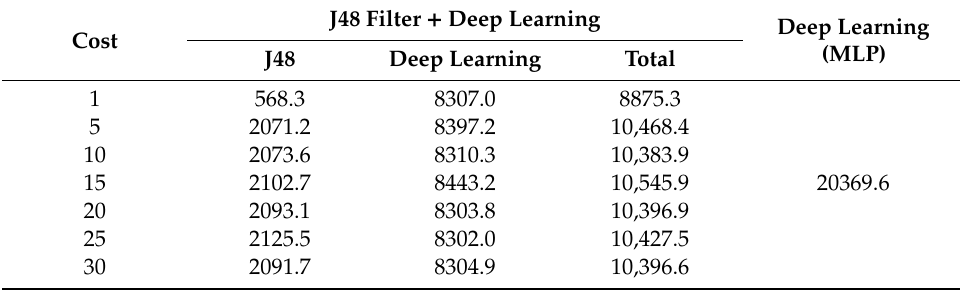
Table 7. Changes in time taken for classification according to cost change (unit: